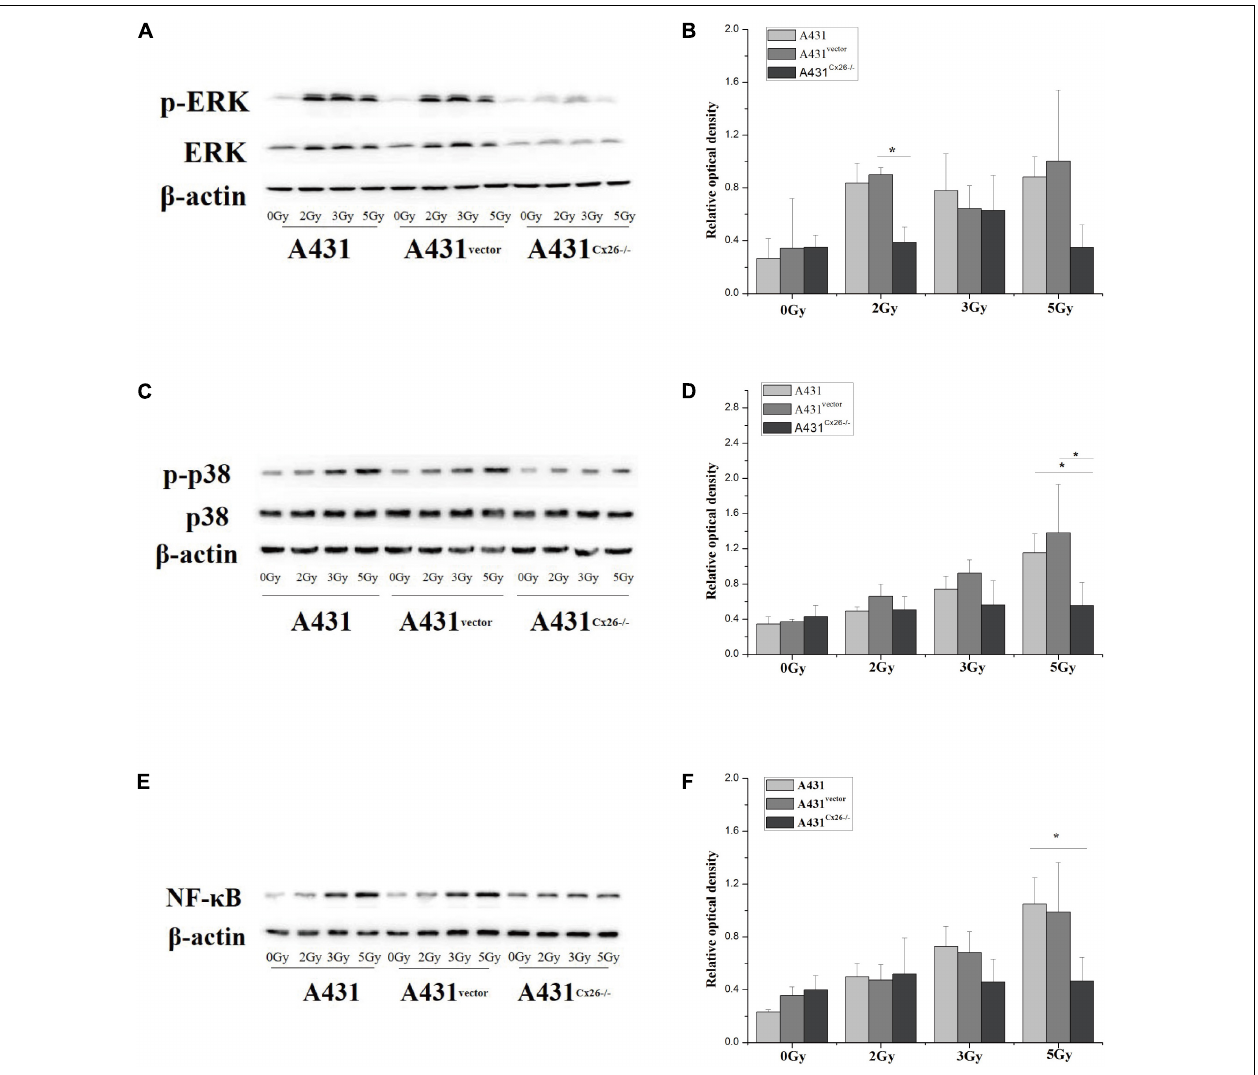
FIGURE 5 | Activation of the MAPK and NF- κ B signaling pathways in A431, A431 vector , and A431 Cx26 − / − cells after irradiation. (A) p-ERK/ERK expression in irradiated A431, A431 vector , and A431 Cx26 − / − cells. (B) Quantification of p-ERK/ERK expression in irradiated A431, A431 vector , and A431 Cx26 − / − cells. (C) Expression of p-p38/p38 in irradiated A431, A431 vector , and A431 Cx26 − / − cells. (D) Quantification of p-p38/p38 expression in irradiated A431, A431 vector , and A431 Cx26 − / − cells. (E) NF- κ B expression in irradiated A431, A431 vector , and A431 Cx26 − / − cells. (F) Quantification of NF- κ B expression in irradiated A431, A431 vector , and A431 Cx26 − / − cells. * p < 0.05 between each cell